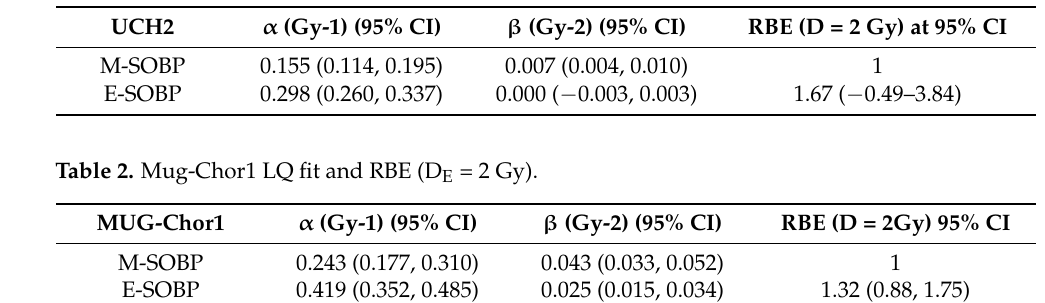
Figure 3. Relative Biological Effectiveness (RBE) of proton beam in the end of spread-out Bragg peak compared to that of the Middle of the Spread-Out Bragg Peak for UCH2 ( left ) and MUG-Chor1 ( right ) chordoma cell killing. Table 1. UCH2 LQ fit and RBE (D E = 2 Gy).